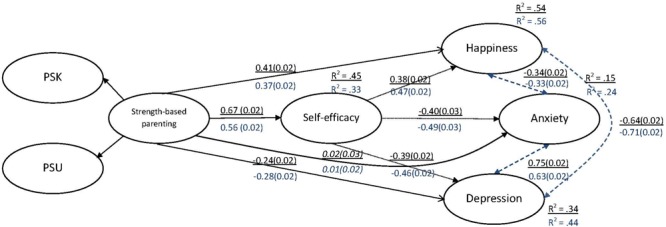
Multigroup analysis of the mediation model across gender. Simultaneously estimated, standardized β weights for the partial invariance mediation model across gender are depicted, with standard error of β in parentheses. Underlined parameters represent the estimates for females, and non-significant (p > 0.05) pathways are denoted in italics. For convenience indirect effects are denoted by dotted lines and correlations by dashed lines. Indicators of the latent factors are not displayed for brevity. PSK, parental strength knowledge; PSU, parental strength use.